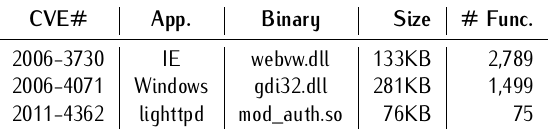
Table 2. Binaries that have real-world